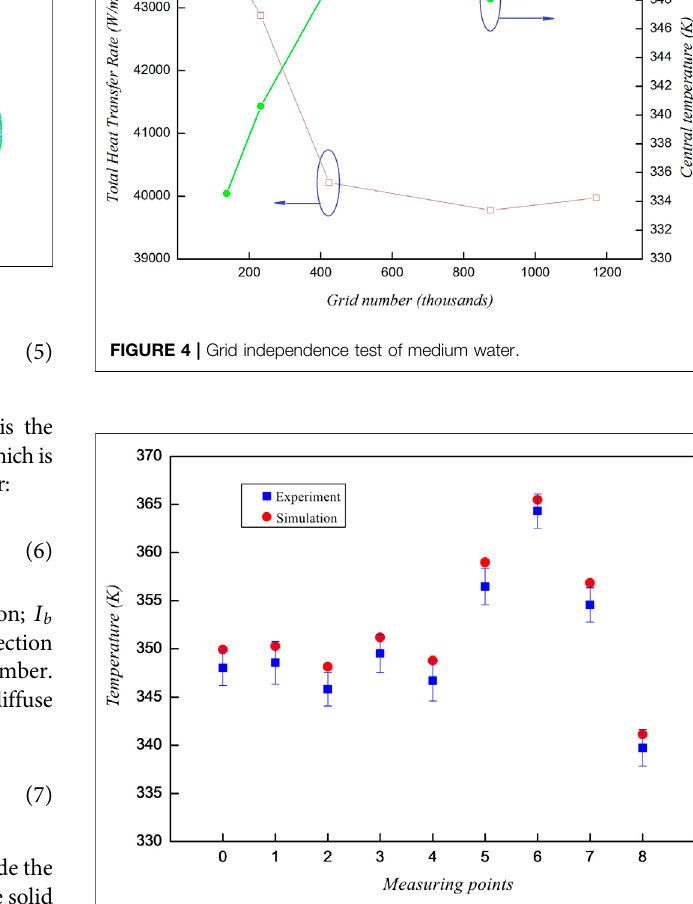
FIGURE 5 | Comparison of the simulation and measurement of temperatures at nine